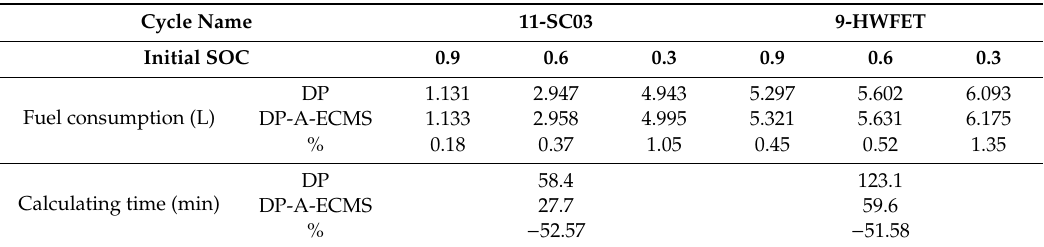
Table 2. O ffl ine optimization of the fuel economy and simulation calculation